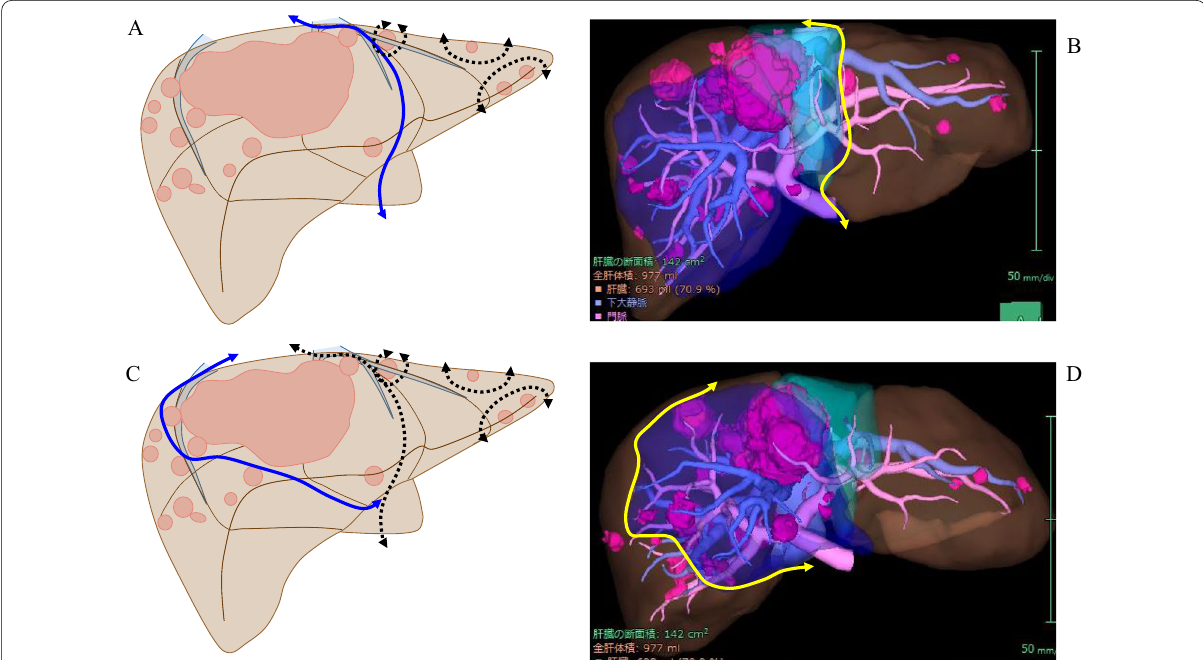
Fig. 3 ALPPS procedure in the present patient. Panel a shows the scheme of parenchymal division at the umbilical fissure (blue line) following 3 partial resections within the left lateral section (black dotted line). Panel b shows territories of S4 portal pedicles (green area) and MHV (blue area) as depicted by 3-dimensional (3D) computed tomography. The resection line at the left umbilical fissure is shown in yellow. Panel c shows an additional line of resection to excise the territories of both S4 and the MHV (in blue). Dotted lines indicate 3 partial resections and the resection line at the umbilical fissure. Panel d shows a 3D-CT image with the line for additional resection of S4 and the MHV territory in yellow